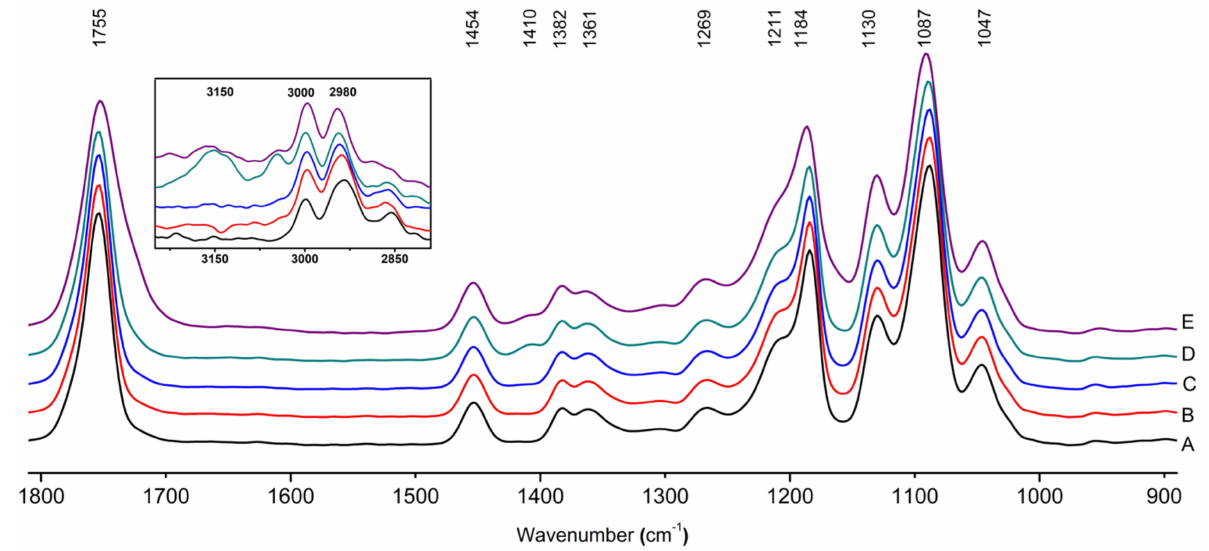
Figure 6. FTIR spectrum of PLA films before (A) and after UV radiation during 2 (B), 5 (C), 24, (D), 144 (E)